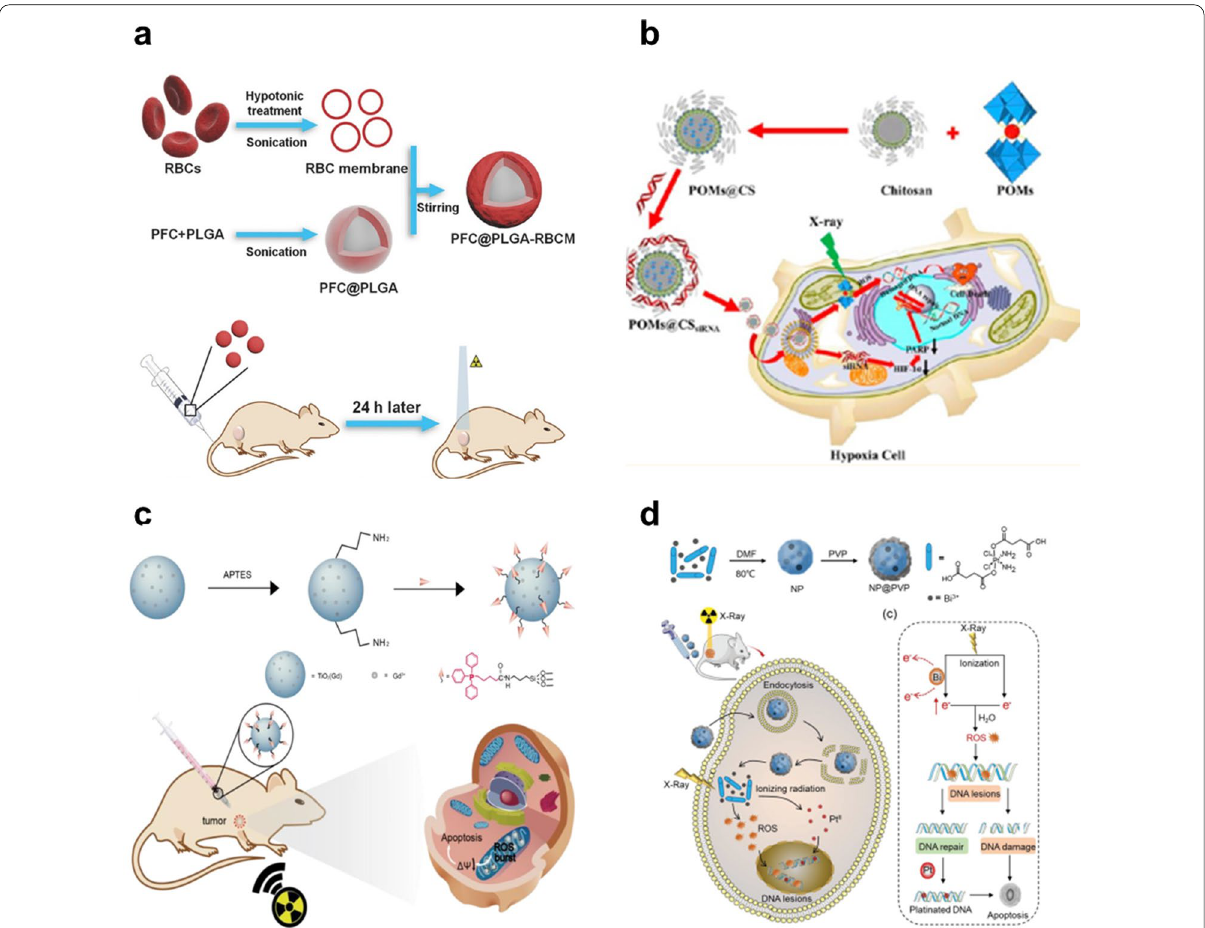
Fig. 6 a Mechanism diagram of the PFC@PLGA-RBCM NPs for RT treatment. b Schematic representation of the GdW10@CS NP for efficient radiosensitization efficacy of RT against hypoxic tumor cells. c Mitochondria-targeted nanosensitizer TiO2 (Gd)-TPP NPs for radiotherapy to trigger mitochondrial ROS accumulation. d Schematic diagram of the synthesis of NP@PVP with bismuth and cisplatin prodrug and the mechanism